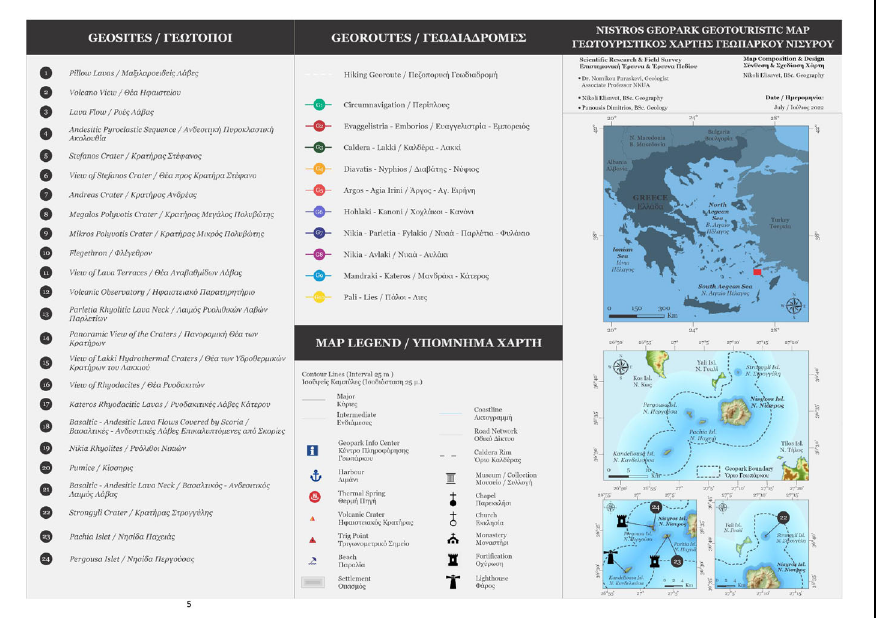
Figure 16. View of the introductory map’s legend and the broader maps that portray the location of Nisyros Geopark, at the beginning of the guidebook, in English and Greek.